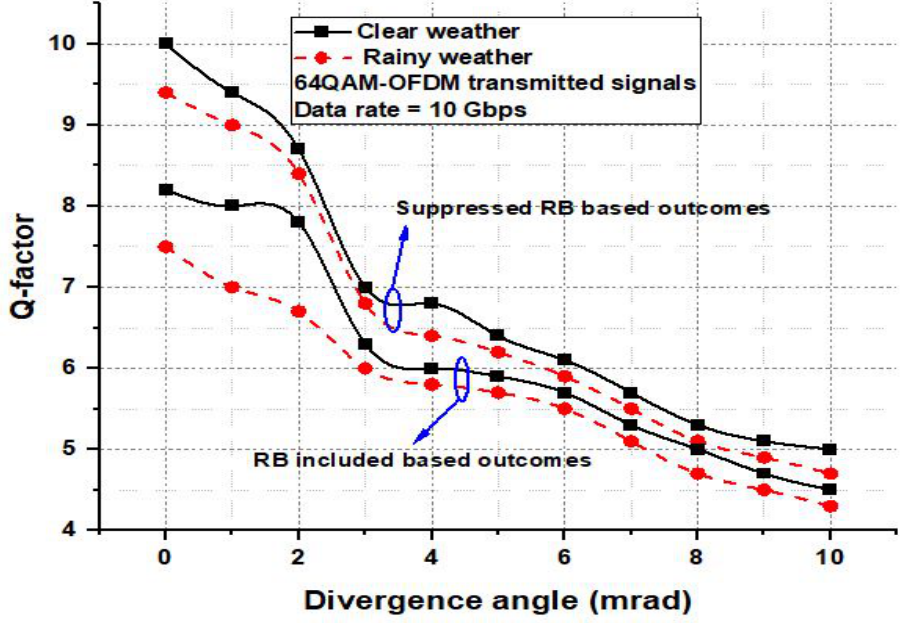
Figure 7. Measuring suppressed and without suppressed RB based WDM-FSO link for 50 GHz channel spacing, 10 Gbps data rate, and 600 m FSO